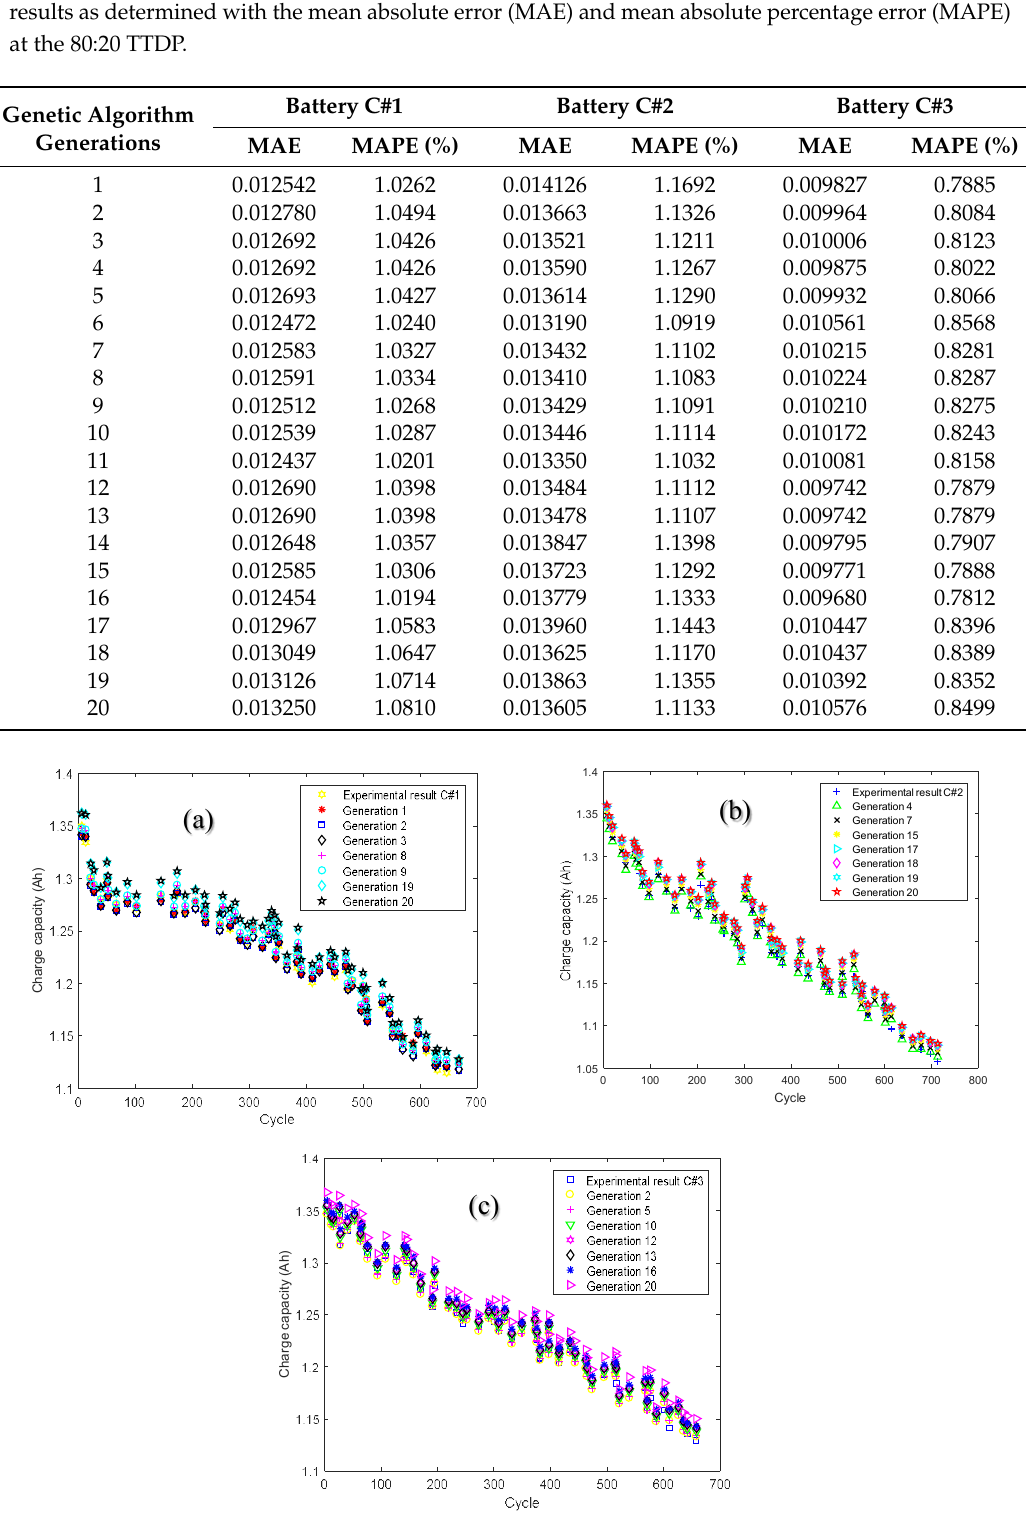
Figure 6. Comparison of some GA-estimated lithium-ion battery charge capacities with the experimental results for 80:20 TTDP, ( a ) battery C#1, ( b ) battery C#2, ( c ) battery C#3.